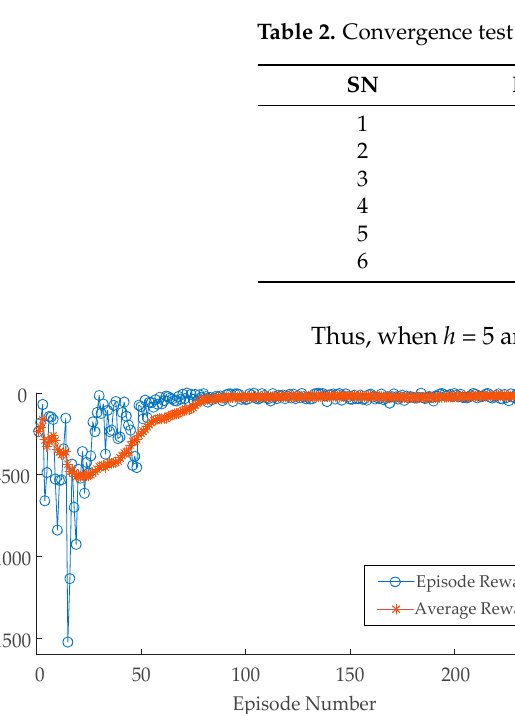
Figure 8. Random perturbation function in the pre-learning phase: ( a ) Random Function of Active Power Disturbance; ( b ) Random Function of EV Output Power Boundary.